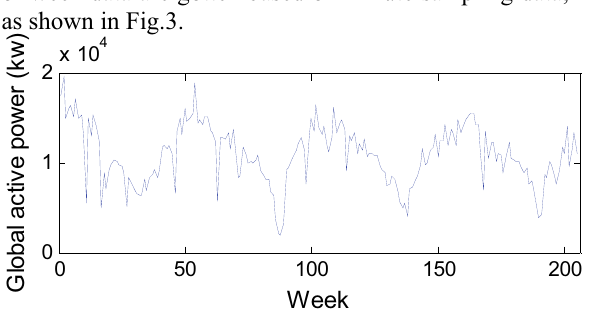
Fig.3. Week time series data